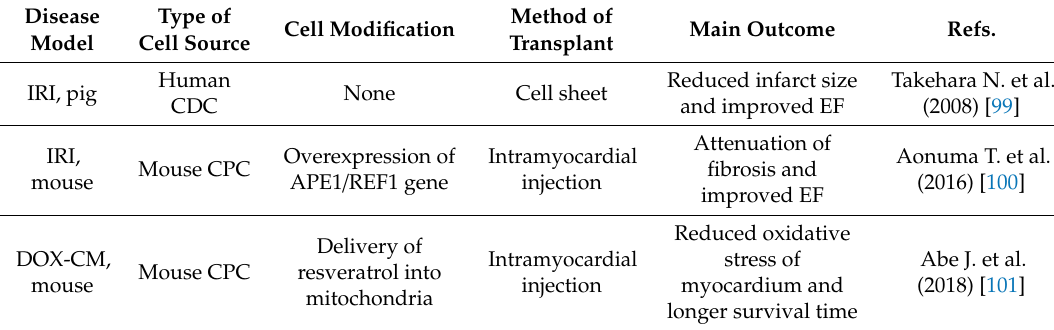
Table 3. Cell therapeutic strategy for treating